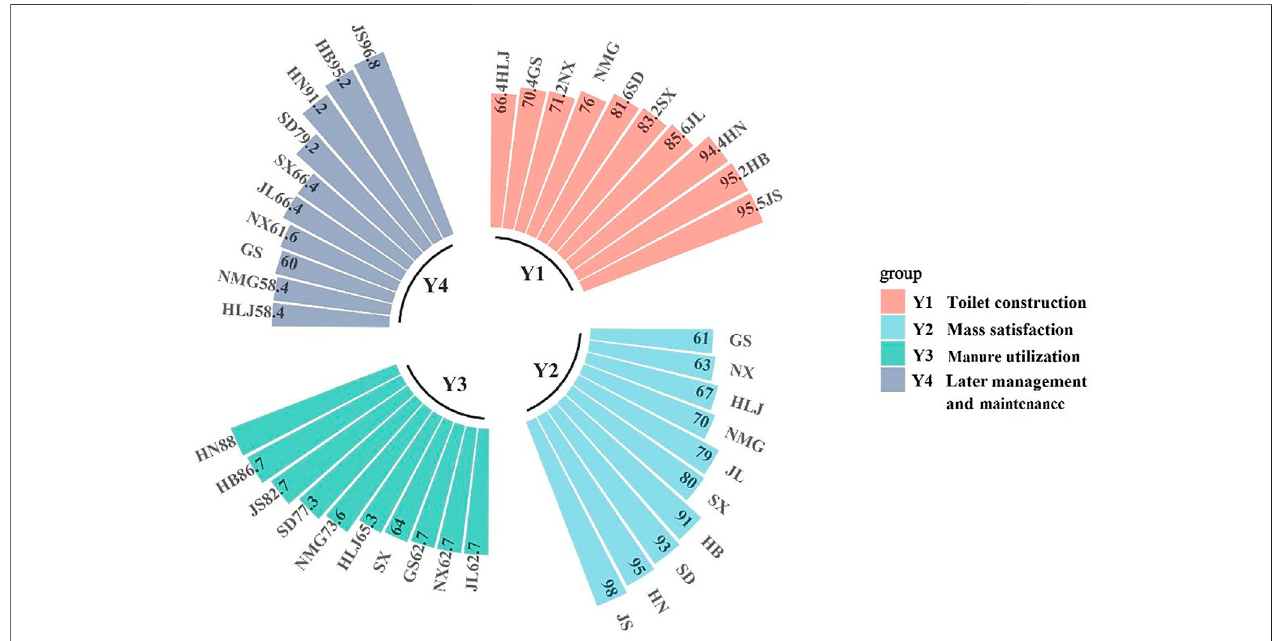
FIGURE 5 | Comprehensive scores of fuzzy evaluations of the second-level indicators of 10 provinces (regions).